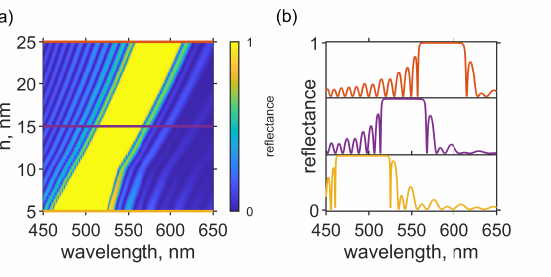
Figure 2. ( a ) Reflectance spectra of the TiO 2 photonic crystal. Increase of the TiO 2 nanotube wall thickness h redshifts the bandgap; ( b ) Cross sections of the reflectance map for h = 5 nm, h = 15 nm and h = 25 nm,